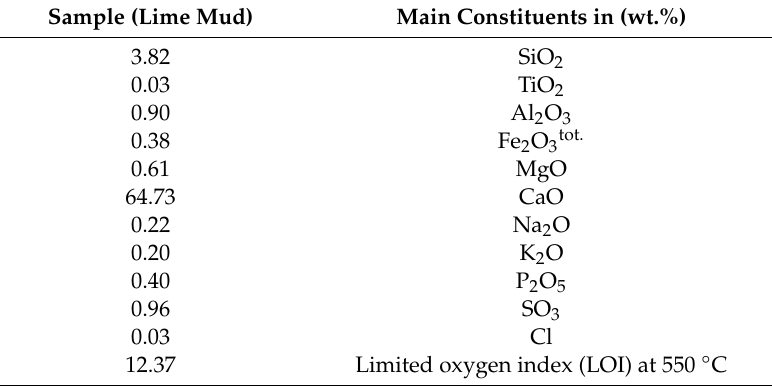
Table 1. Chemical constituent of the oxide composition in the carbonated mud waste CMW using X-ray fluorescence spectrometers (XRF)